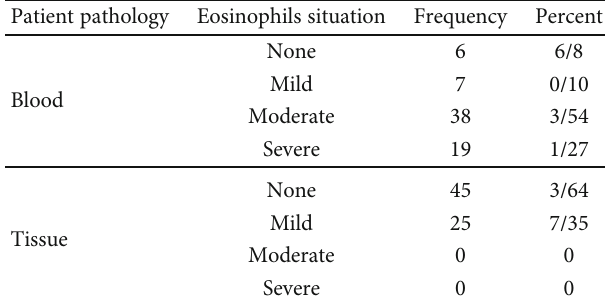
Table 1: Relative frequency of blood and tissue eosinophil status in